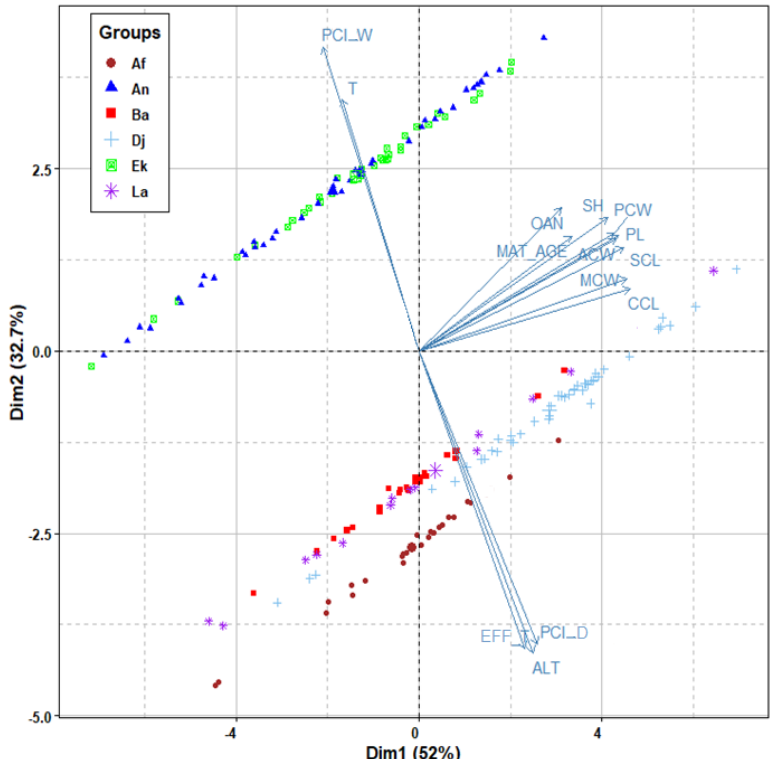
Figure 5. PCA of the tortoise body sizes of adult females and their age at maturity in the six studied populations in relation to the most contributory climatic variables. Alt: altitude, EFF-T: effective temperature, PCI D: precipitation concentration index for the dry season, PCI W: precipitation concentration index for the wet season, T: mean daily maximum temperature for March, Ek: El Kala; An: Annaba; Ba: Batna; Dj: Djelfa; La: Laghouat; Af: Aflou. Abbreviated characteristics of body size are explained in the Materials and Methods section.